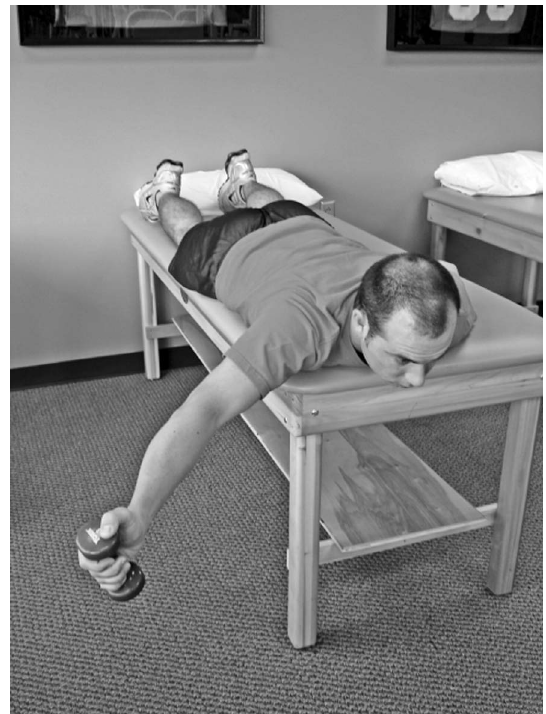
Figure 5. An example of open chain exercise that promotes engagement of the rhomboid and the